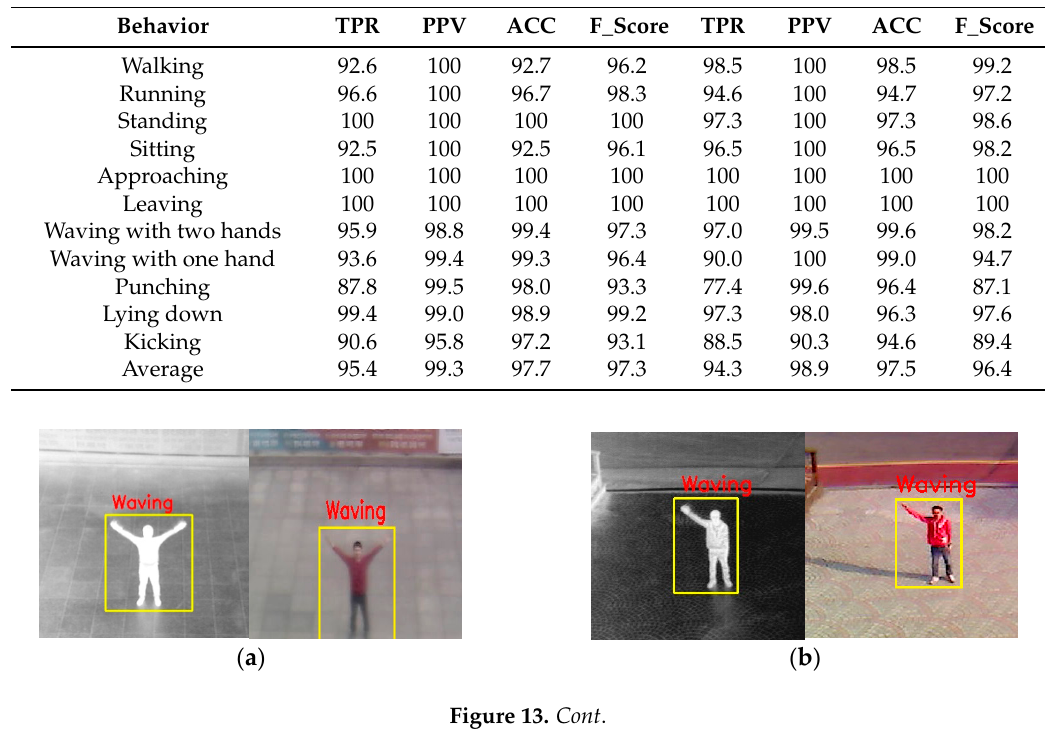
Figure 13 . Cont. Figure 13. Cont